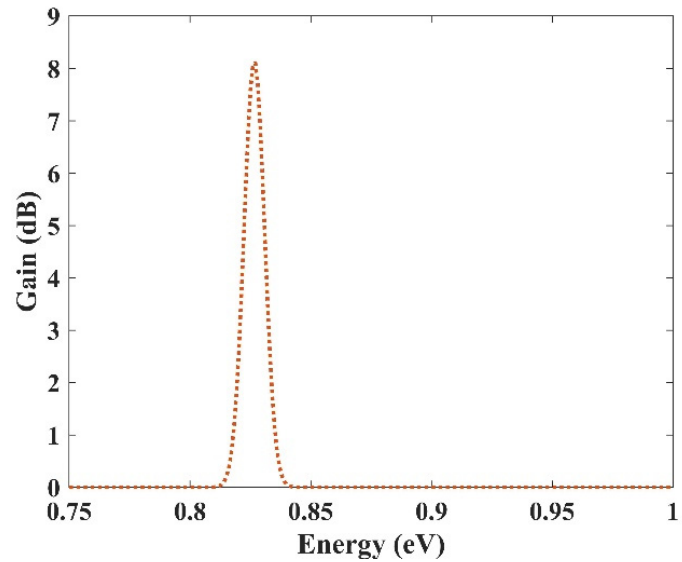
Figure 13. Selective amplification for channel 2 (1500 nm).